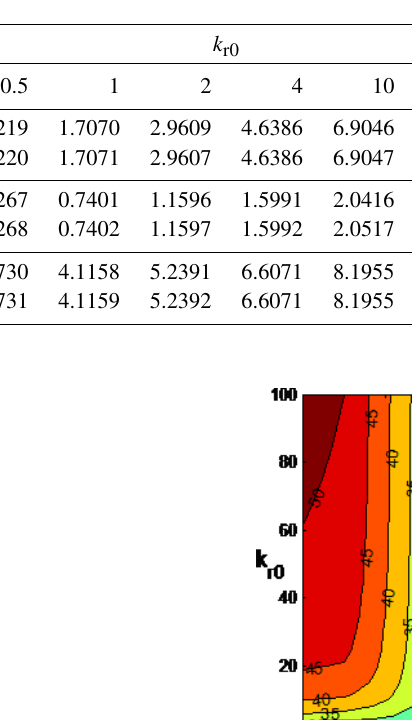
Table 2. Critical buckling load p ( q = 0) for various elastic constraints values with k t = 0 and µ = 0 (local column).